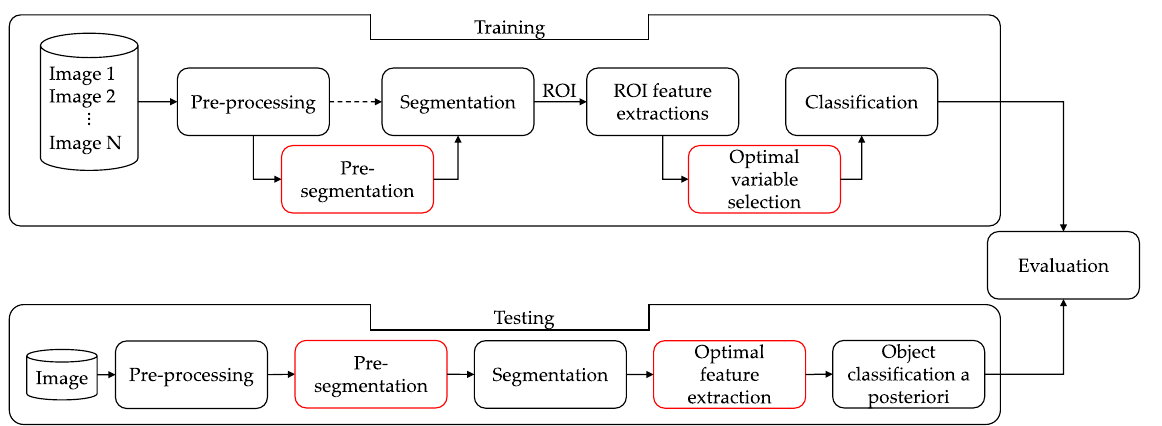
Figure 3. Proposed PSEV-BF methodology with pre-processing, pre-segmentation, segmentation, ROI feature extraction, optimal variable selection, classification, and evaluation.